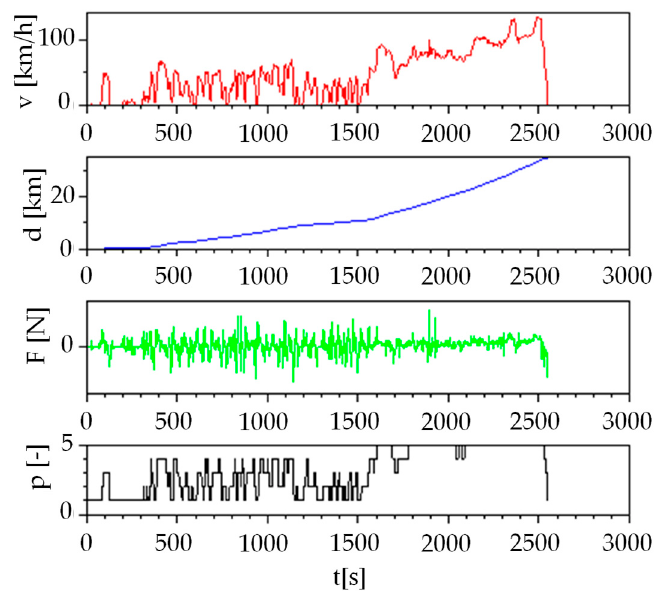
Figure 2. Parameters obtained from the block responsible for generating the WLTP test signal.